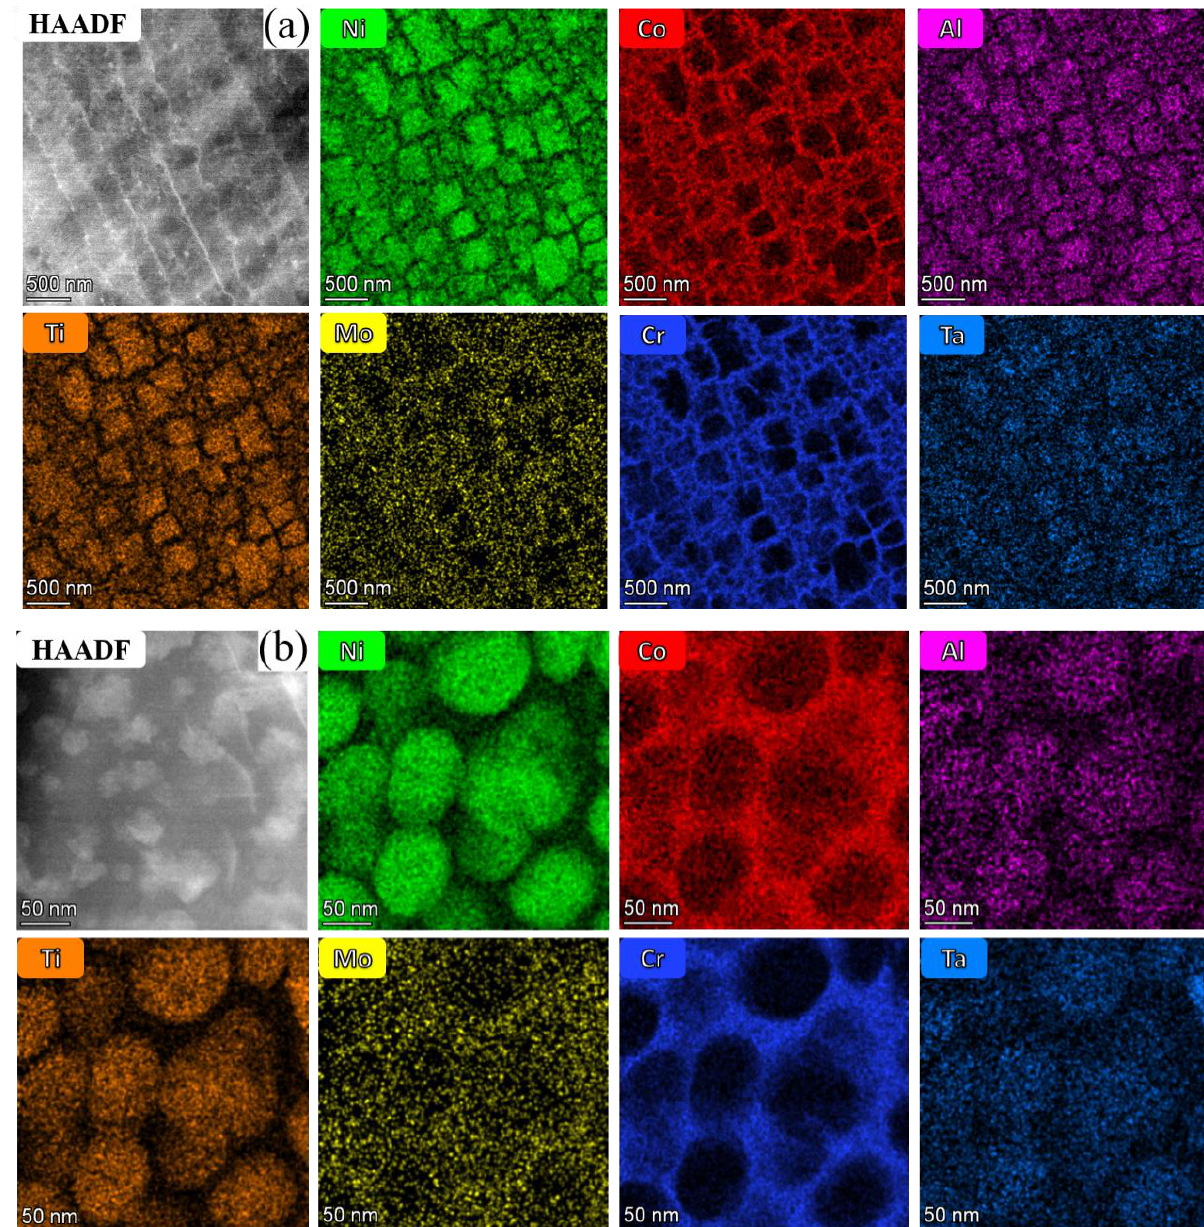
Figure 9. ( a ) HAADF-STEM images of the γ′ precipitates and corresponding EDS mappings in 13Co. ( b ) HAADF-STEM images of the γ′ precipitates and corresponding EDS mappings in 35Co.